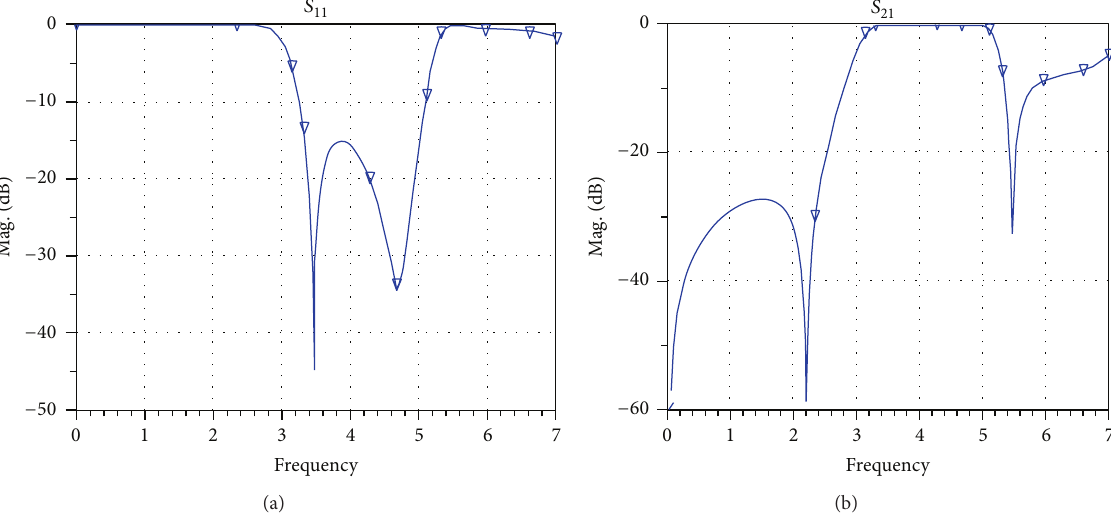
Figure 16: Frequency response of the simulated filter of[2] in the workspace of ADS plotted versus (a) return losses (𝑆 11 ) and (b) insertion losses (𝑆 21 ) .